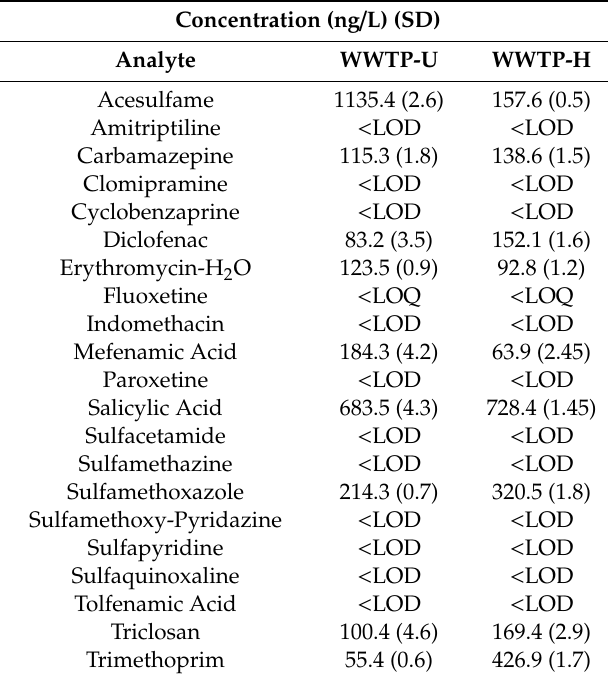
Table 2. Mean concentrations (n = 3) with Standard Deviation (SD) of target analytes in